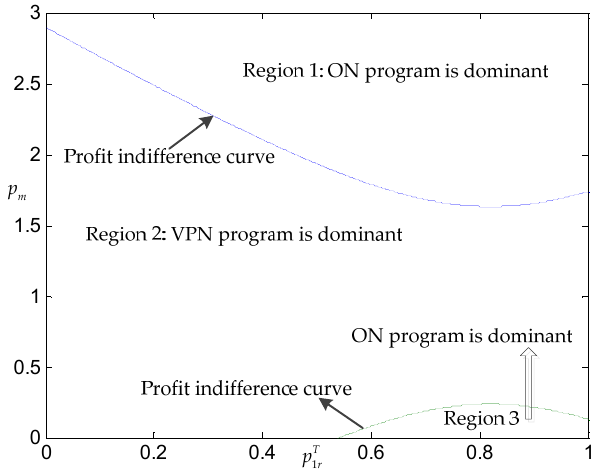
Figure 8. The dominant scenario of trade-in program (varying the trade-in and retail prices).